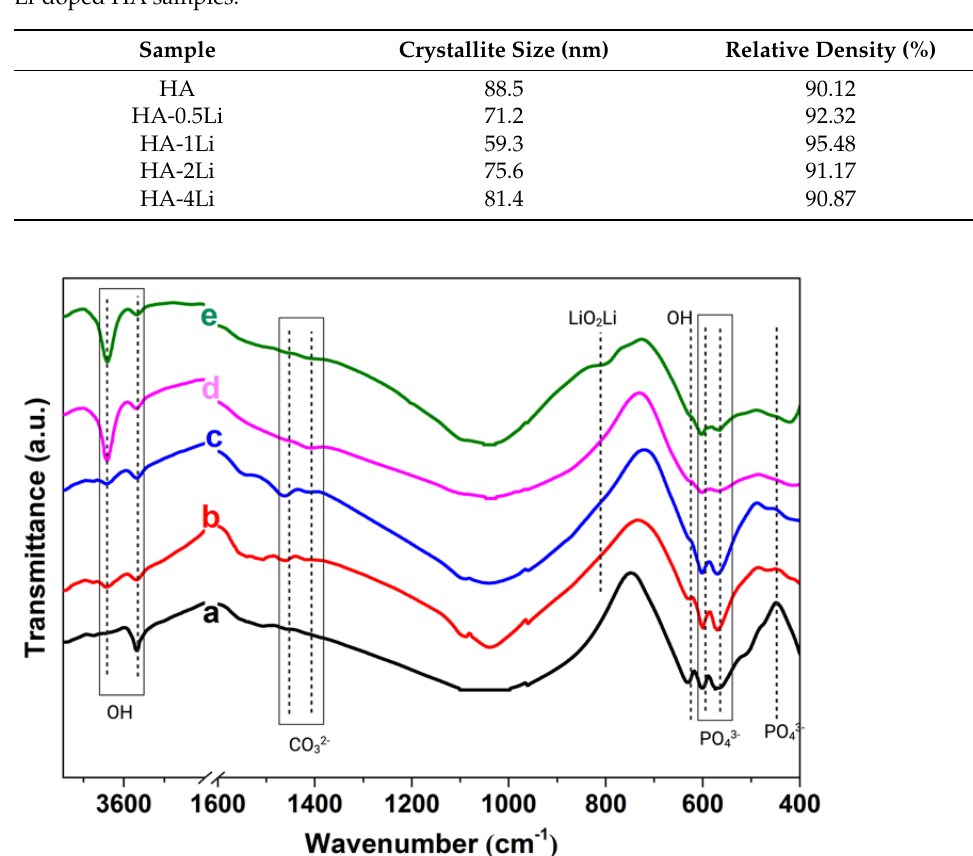
Figure 2. FTIR spectrum of: ( a ) HA. ( b ) HA-0.5Li. ( c ) HA-1Li. ( d ) HA-2Li. ( e ) HA-4Li sintered at 1250 °C.